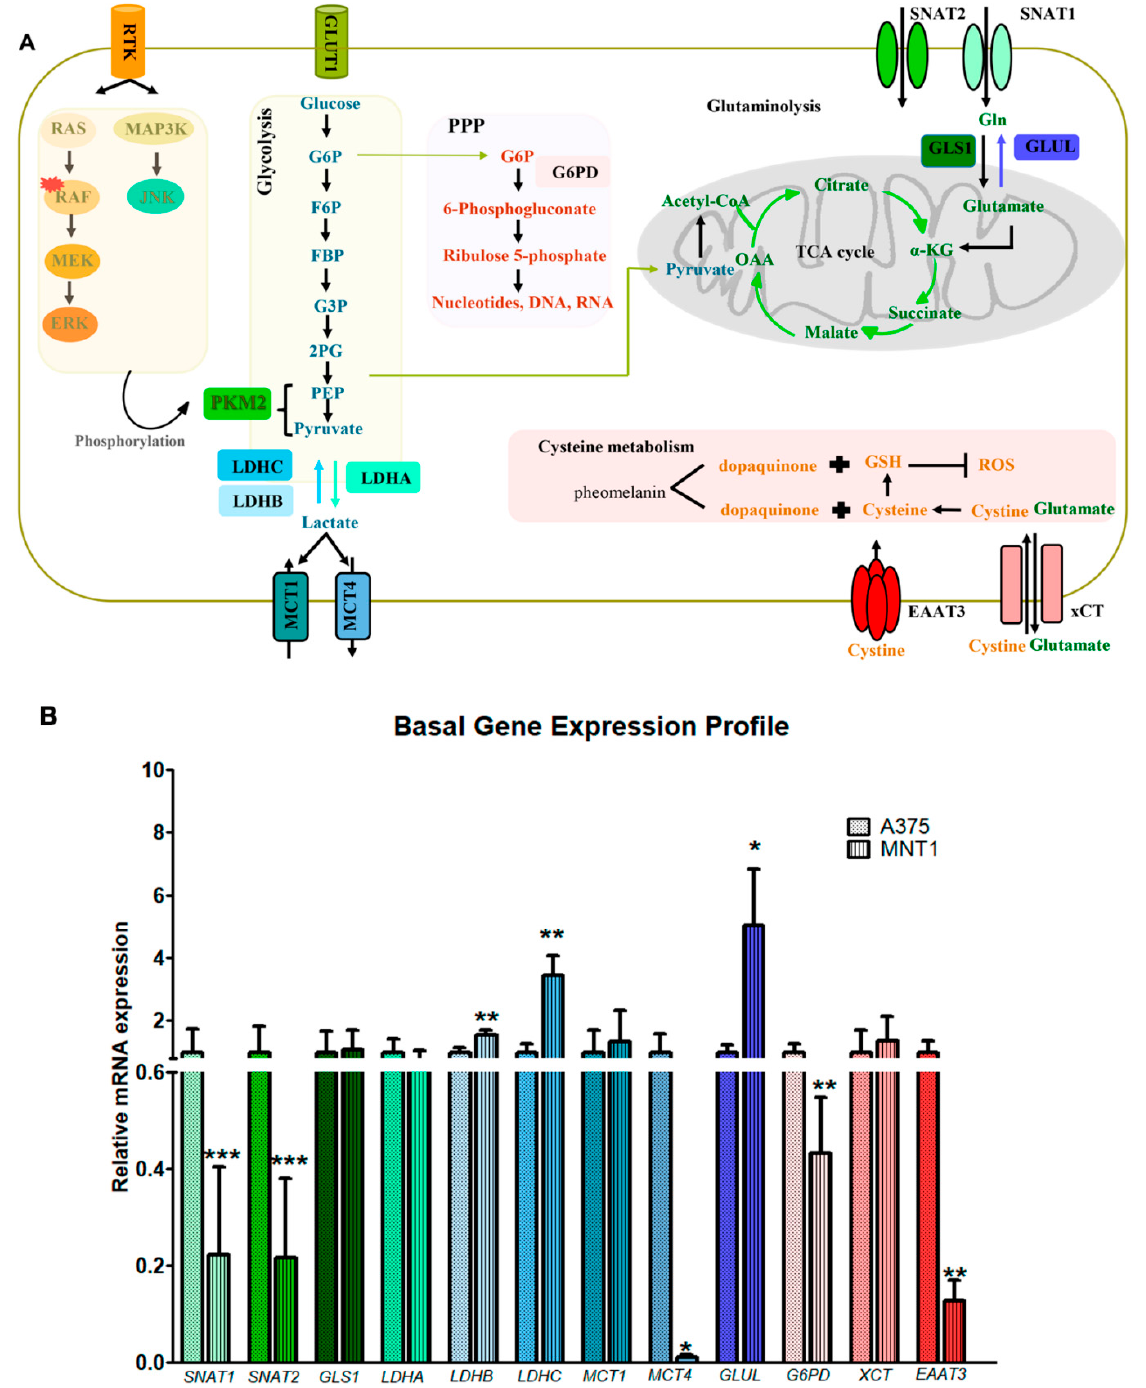
Figure 2. Metabolic characterization of A375 and MNT1 melanoma cells. ( A ) Schematic representation of the main metabolic pathways activated in melanoma cells and their association with MAPK pathways (c-Jun N-terminal kinase (JNK) and extracellular signal-regulated kinase (ERK) activation). Glycolysis, pentose phosphate pathway (PPP), TCA cycle, glutaminolysis, and cysteine metabolism are the main metabolic pathways represented. ( B ) Expression analysis of several genes involved in the metabolic pathways previously mentioned in A375 and MNT1 cells by RT qPCR. Error bars represent the standard deviation of mean values obtained from triplicate experiments. Student’s t -test was used to compare two independent groups * p < 0.05; ** p < 0.01; and *** p < 0.001. This gene expression analysis showed the downregulation of genes encoding trans- porters involved in the uptake of neutral α -amino-acids, mostly glutamine, such as SNAT1